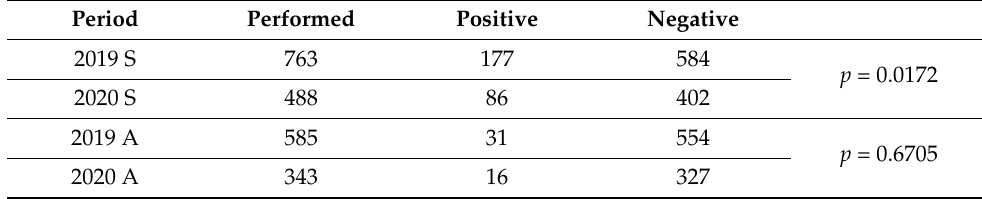
Table 9. Comparison of rotavirus